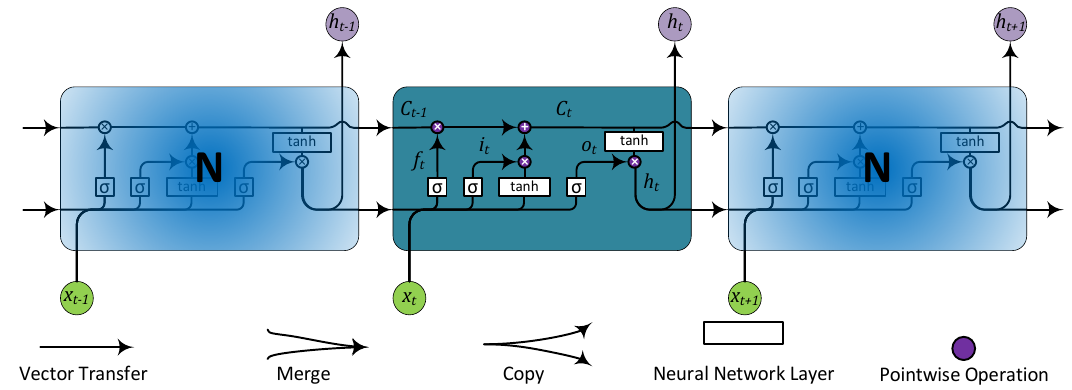
Figure 2. 1D CNN process.